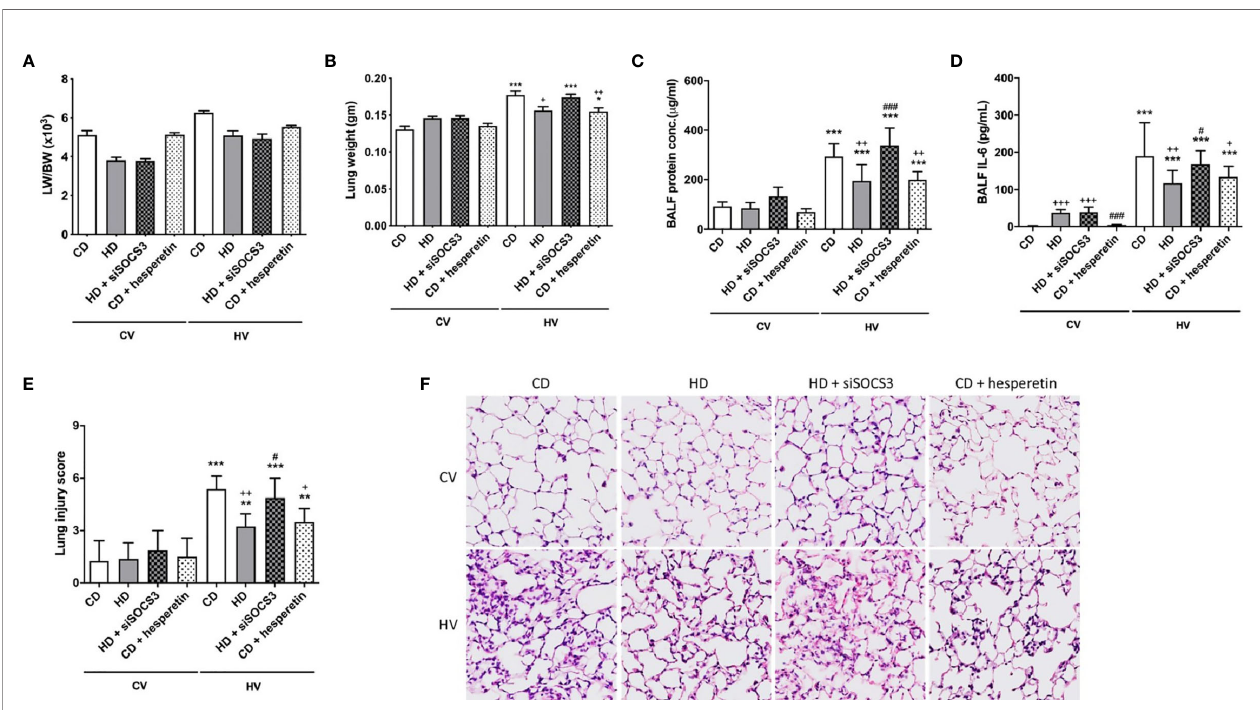
FIGURE 2 | The effects of obesity and SOCS3 manipulation on ventilator-induced lung injury. These parameters were collected in nonobese mice (CD), obese mice (HD), obese mice pretreated with an intratracheal spray of a SOCS3 siRNA (HD + siSOCS3), and nonobese mice pretreated with hesperetin enterally (CD + hesperetin). They were measured after 6 h of spontaneous breathing (CV) or mechanical ventilation (HV). (A) Lung-to-whole-body weight ratio. (B) Lung weight alone. (C) BALF protein concentration. (D) BALF IL-6 level. (E) Lung injury score. (F) Hematoxylin and eosin staining of pathological specimens (magni fi cation, 400×). BALF, bronchoalveolar lavage fl uid. Data are expressed as the mean ± SD (n = 5 per group). * P < 0.05, ** P < 0.01 and *** P < 0.001 compared with the corresponding group in the CV condition. + P < 0.05, ++ P < 0.01, and +++ P < 0.001 compared with the nonobese mouse group (CD). # P < 0.05 and ### P < 0.001 compared with the obese mouse group (HD).